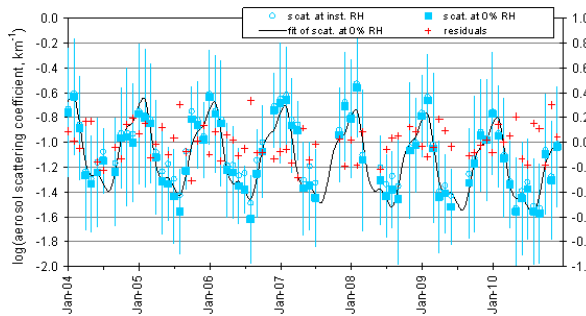
Figure 1. Variations in PM 2 . 5 at IPR: logarithm of the monthly mean values (squares), least mean square fit (line), and residuals (crosses, right axis). Error bars show the standard deviation of the log of the monthly averages.